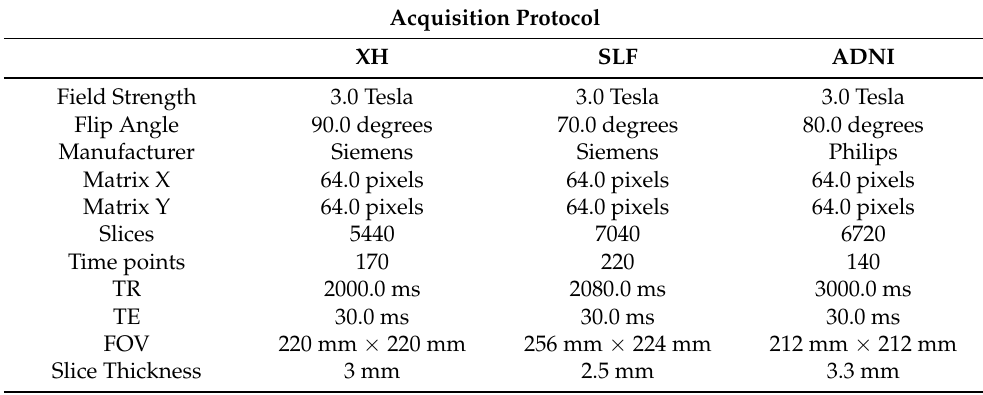
Table 2. Data acquisition protocol for dataset from Xuanwu Hospital (XH), Santa Lucia Foundation (SLF) and